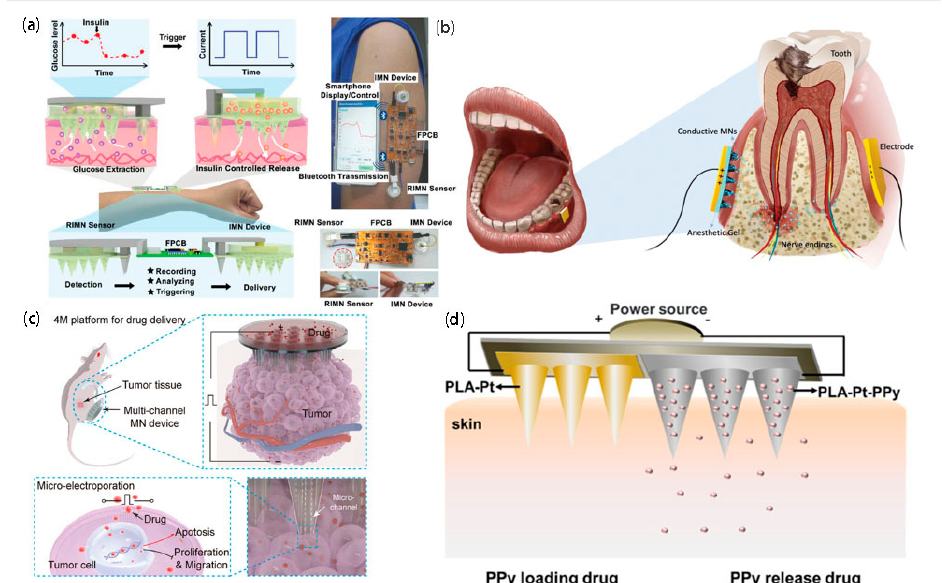
Figure 5. Practical application of drug release. ( a ) MN-based system for real-time and in situ diabetes monitoring and treatment by wirelessly communicating with a smartphone for data transmission and display [58]; copyright 2021, John Wiley and Sons. ( b ) Schematic diagram demonstrating the enhanced effect of conductive MNs on ITP for directed delivery of anesthetic drugs to deep tissues in dentistry [36]; copyright 2021, Wiley-VCH GmbH. ( c ) Schematic diagram of a platform for local administration in vivo. The inset shows an enlarged detail of the platform attached to a solid tumor. An external electric field is applied from the needle tip to the bottom (top) of the drug reservoir of the device. The lower right panel illustrates the drug delivery process at a single MN level. The illustration on the left shows that the drug molecules enter the tumor cells by electroporation, exerting their anticancer effects [23] ; copyright 2021, Wiley-VCH GmbH. ( d ) Schematic diagram of drug release from a controlled transdermal drug delivery system by electrical triggering [59] ; copyright 2022, American Chemical Society.